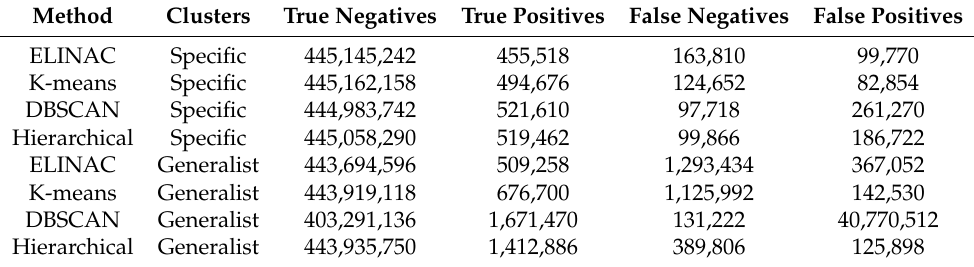
Table 7. Evaluation of each method’s performance when assigning records to specific and general- ist